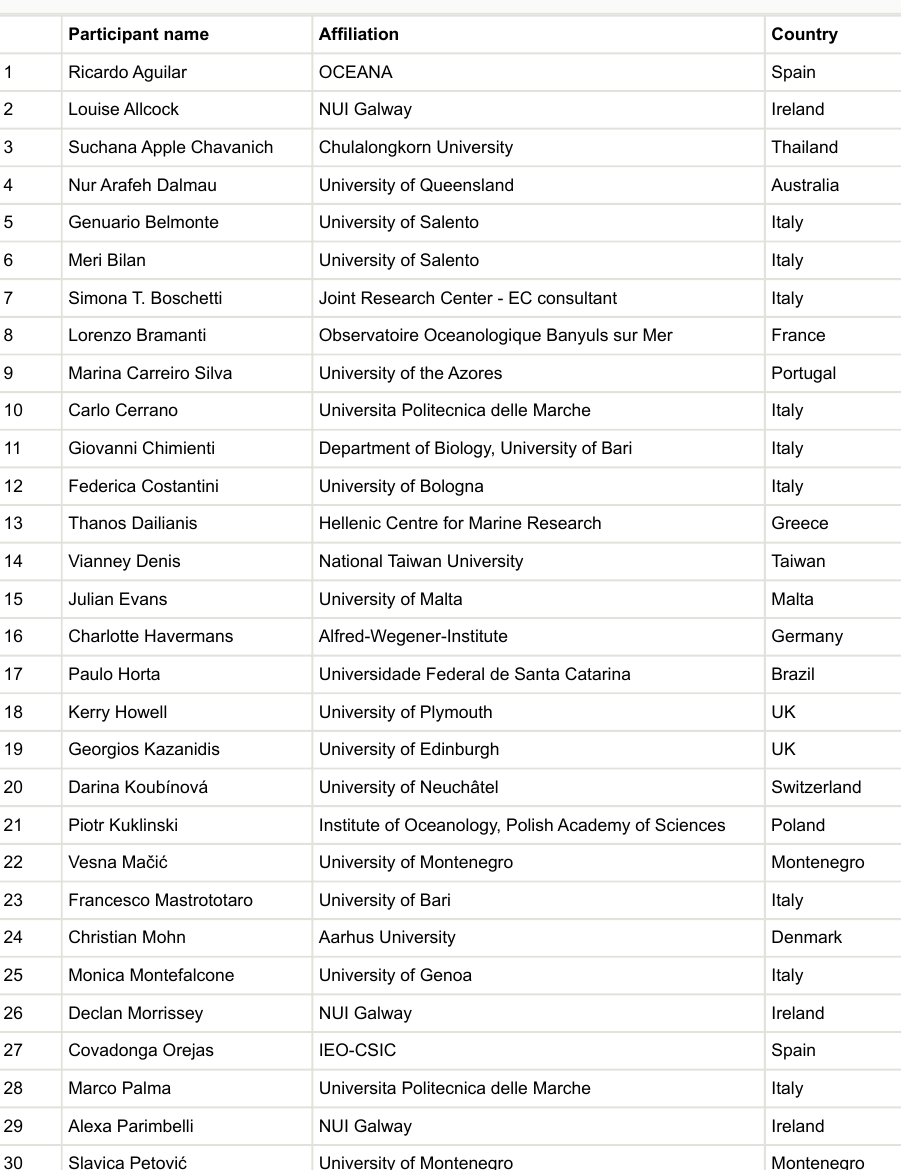
workshop’s results. The majority of the participants were from European countries, but there were also participants from Brazil, Japan, Thailand, Australia, Taiwan and South Africa (Table 1) (Fig. 1). Table 1. List of participants (in alphabetical order) in the workshop, including affiliation and